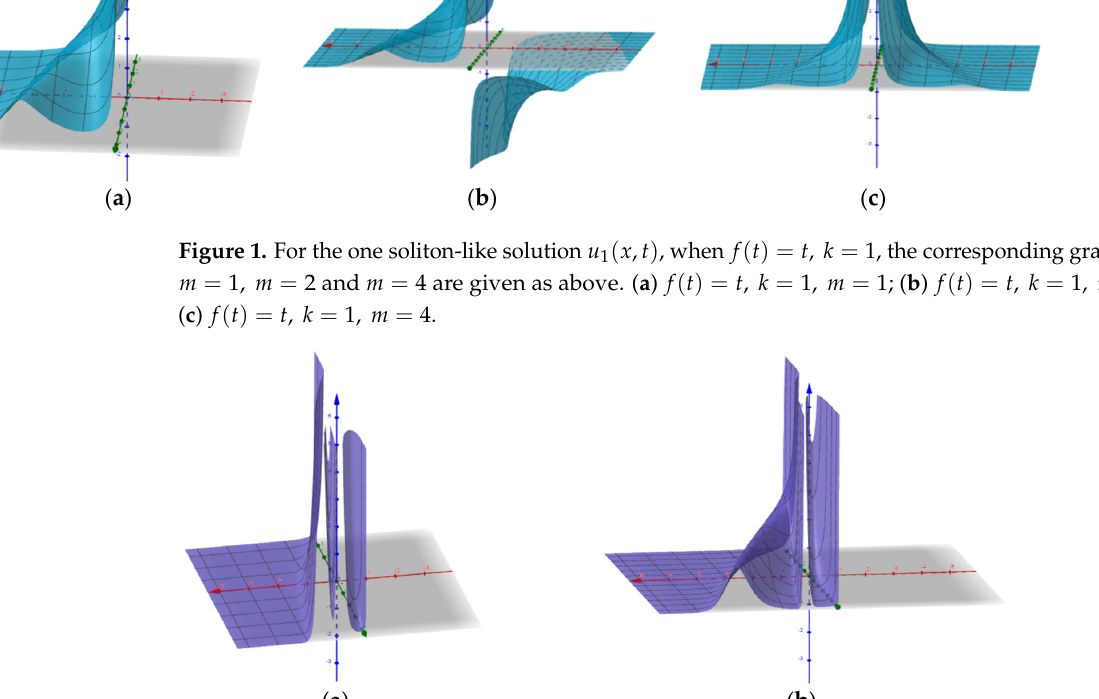
Figure 2. For the two soliton-like solution u 2 ( x , t ) , when f ( t ) = t , m = 1, the corresponding figures of k 1 = 2, k 2 = 3 and k 1 = 3, k 2 = 1 are given as above. ( a ) f ( t ) = t , m = 1, k 1 = 2, k 2 = 3; ( b ) f ( t ) = t , m = 1, k 1 = 3, k 2 = 1.